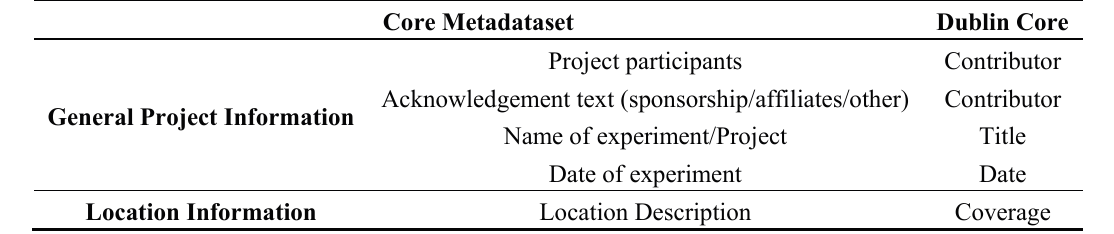
Table A4. Mappings from Dublin Core 1.1 to the Core Metadataset.